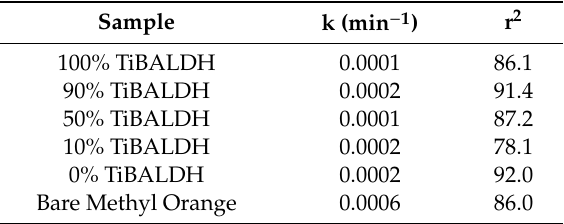
Table 4. Reaction rate constant and r 2 values for the photocatalytic degradation of methyl orange in visible light.